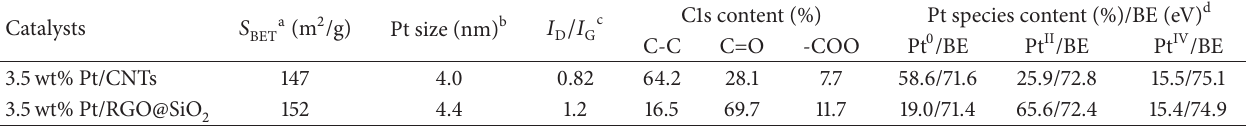
Table 1: Physicochemical properties of 3.5 wt% Pt/CNTs and 3.5 wt% Pt/RGO@SiO 2 . Catalysts